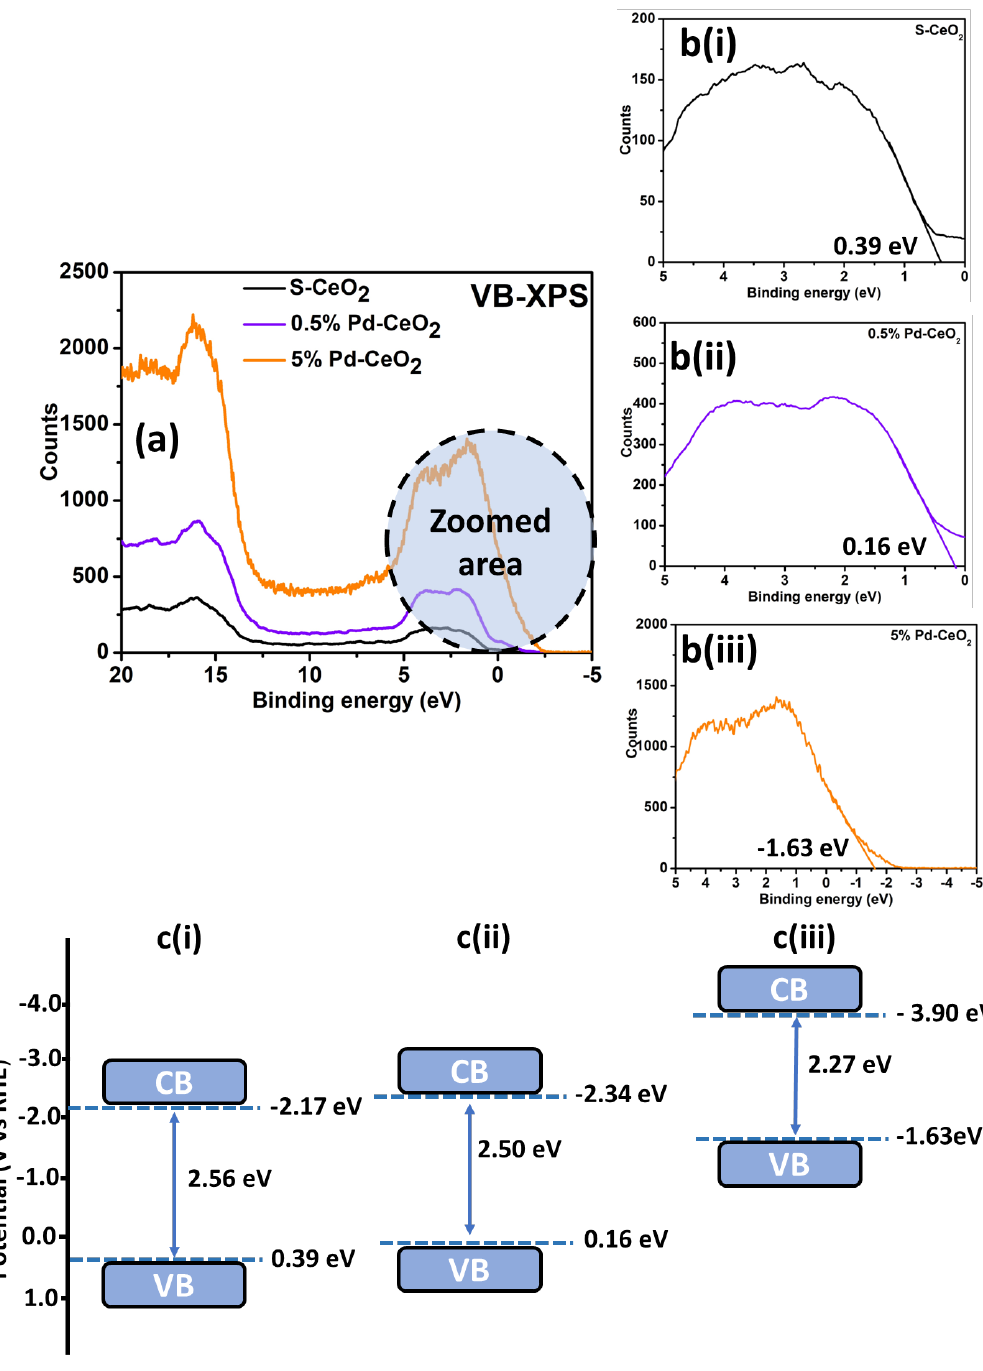
Figure 3. ( a ) Valence band XPS spectra of S − CeO 2 , 0.5% Pd − CeO 2 , and 5% Pd − CeO 2 NP; ( b ) zoomed valence band spectra of ( i ) S − CeO 2 , ( ii ) 0.5% Pd − CeO 2 , and ( iii ) 5% Pd − CeO 2 to estimate the band gap; and ( c ) proposed density of electronic states (DOS) for ( i ) S − CeO 2 , ( ii ) 0.5% Pd − CeO 2 , and ( iii ) 5% Pd − CeO 2 NPs.